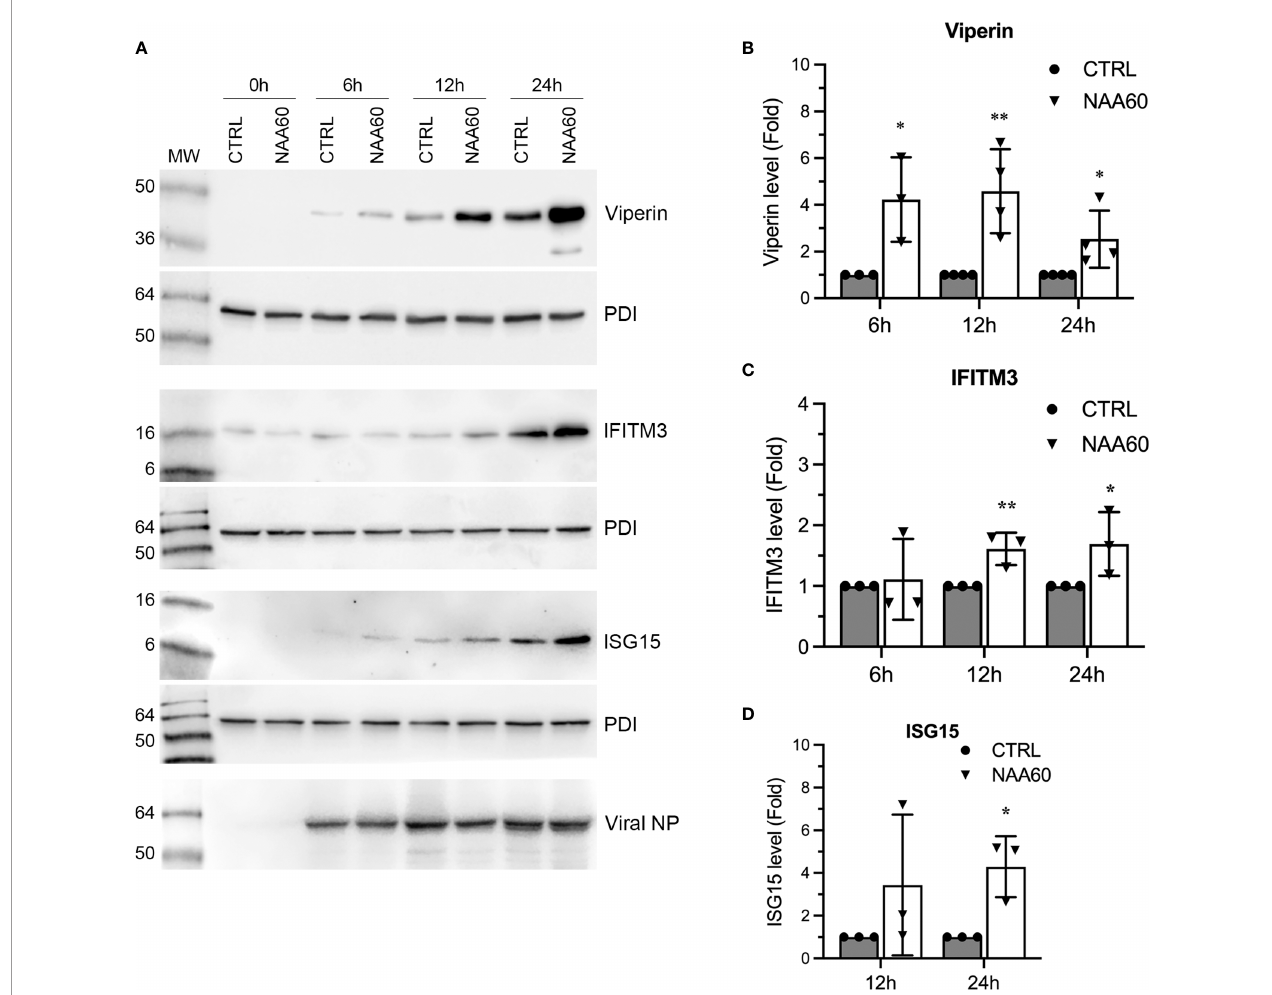
FIGURE 6 | The depletion of NAA60 increases IAV-induced viperin, IFITM3, and ISG15 polypeptide levels. A549 cells were transfected with 10 nM of CTRL or NAA60 siRNA for 72 h. One set of the cells was processed to con fi rm the depletion of NAA60 by RT-qPCR as in Figure 1A (not shown). The other set of the cells was infected with PR8 at an MOI of 1.0 for 0 h, 6 h, 12 h, or 24 h, and the cells were processed to detect the viperin (42 kDa), IFITM3 (15 kDa), ISG15 (15 kDa), viral NP and PDI polypeptide levels by western blotting (A) . The intensity of viperin, IFITM3, ISG15 and corresponding PDI bands at 6 h, 12 h, and 24 h timepoints was quanti fi ed. Then, the amount of viperin, IFITM3, and ISG15 was normalized by the PDI amount at corresponding timepoints. The normalized values of viperin (B) , IFITM3 (C) , and ISG15 (D) in CTRL siRNA transfected cells at indicated timepoints were considered 1-fold to determine their amounts in NAA60 siRNA transfected cells at corresponding timepoints. Error bars represent means ± standard deviation of at least three biological replicates; **P ≤ 0.01, *P ≤ 0.05. MW, molecular weight; Grey bar, CTRL; White bar,